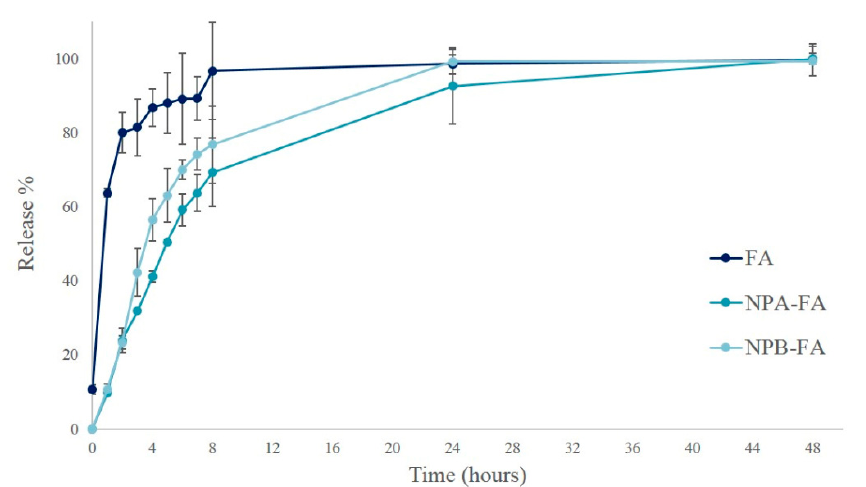
Figure 3. In vitro release profiles of pure drug, NPA-FA and NPB-FA in phosphate buffered solution (pH 7.4) at 37 °C.